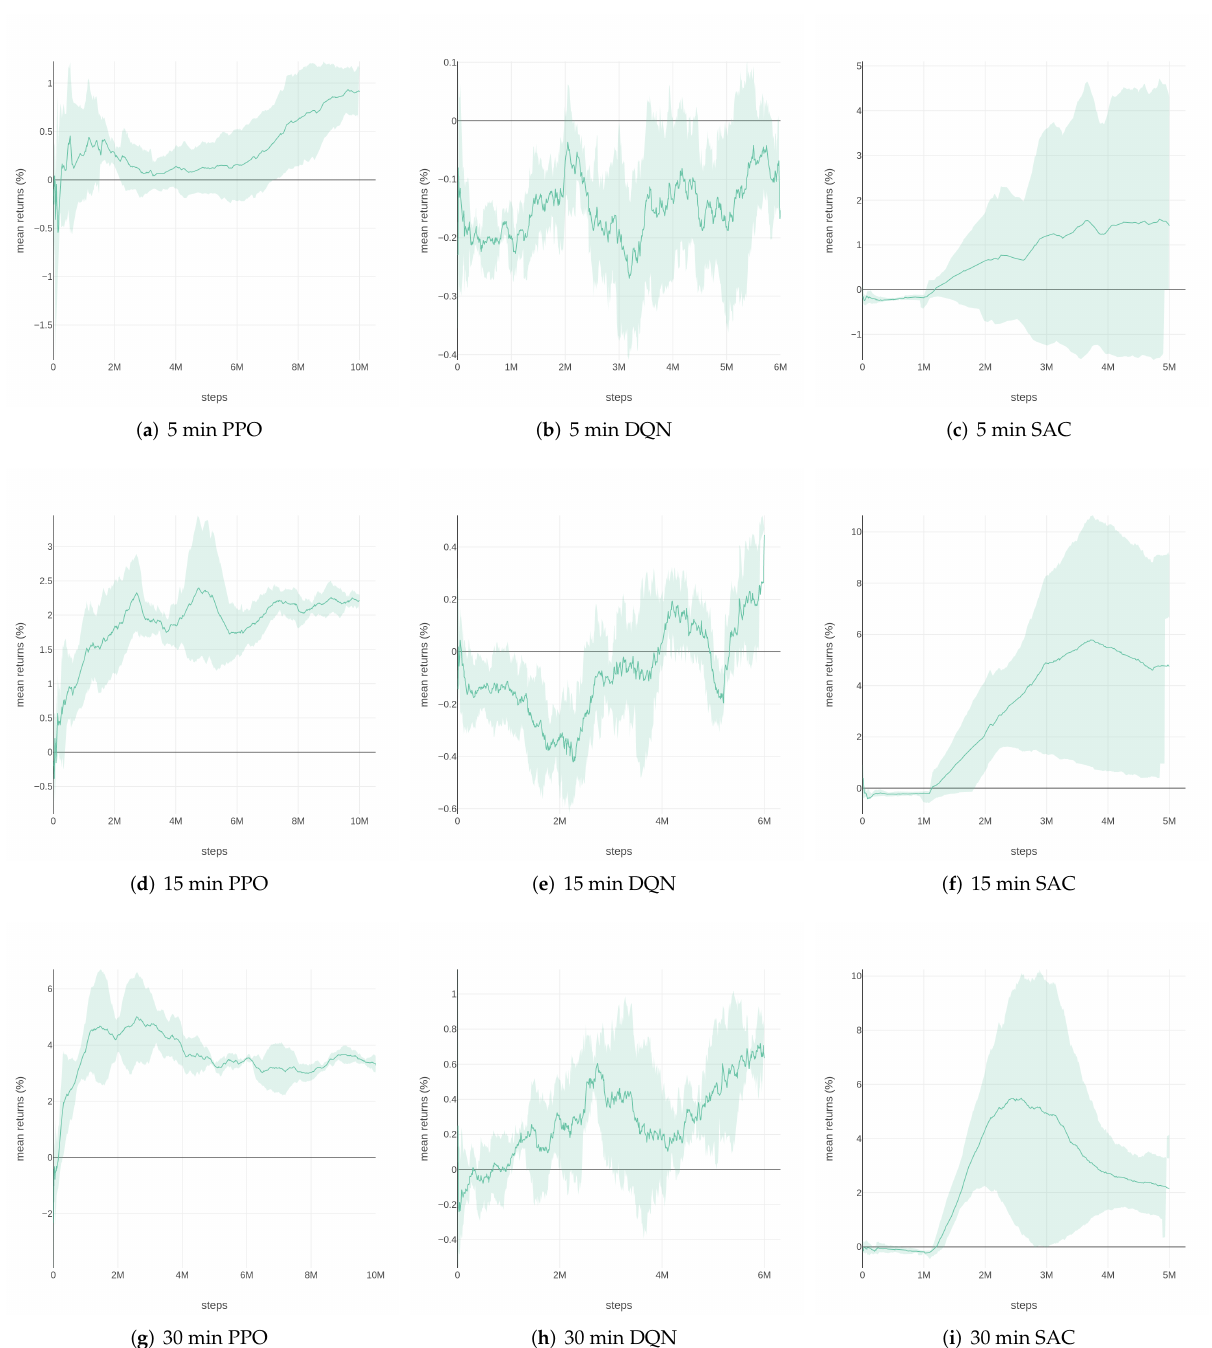
Figure 5. Training results on 50 ETF in three different time intervals using PPO, DQN, and